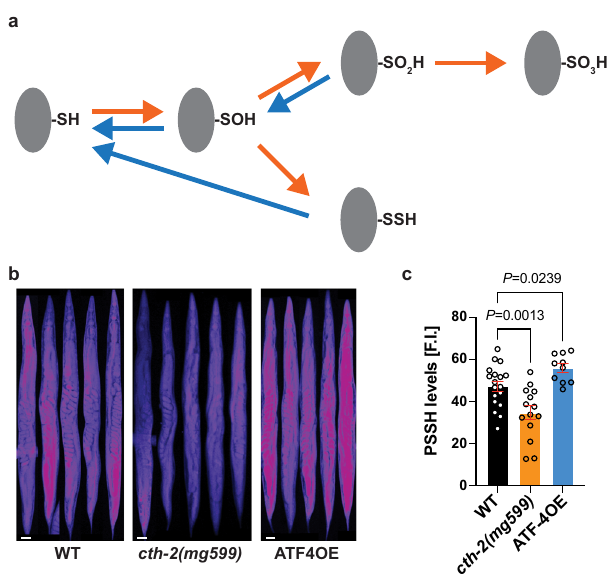
Fig. 5 ATF-4 and CTH-2 regulate protein persul fi dation levels. a Schematic diagram showing that the thiol group ( – SH) of reactive cysteine residues in proteins can undertake various redox states. Sulfenylation ( – SOH) can be reversed, particularly ef fi ciently through the intermediate of persul fi dation ( – SSH), but sul fi nylation ( – SO 2 H) is reversible only within peroxiredoxins and sulfonylation ( – SO 3 H) is irreversible 35,37 . Arrows in orange indicate oxidation processes while those in blue indicate reduction processes. b Representative fl uorescent images and quanti fi cation ( c ) showing that ATF-4OE exhibited higher persul fi dation levels, while cth- 2(mg599) animals exhibited lower global persul fi dation levels, compared to WT. Data are represented as Mean ± SEM. n = 3 biological replicates of at least 10 worms per condition. Scale bar = 50 μ m. F.I. = fl uorescent intensity. P values to WT are unpaired t -test,